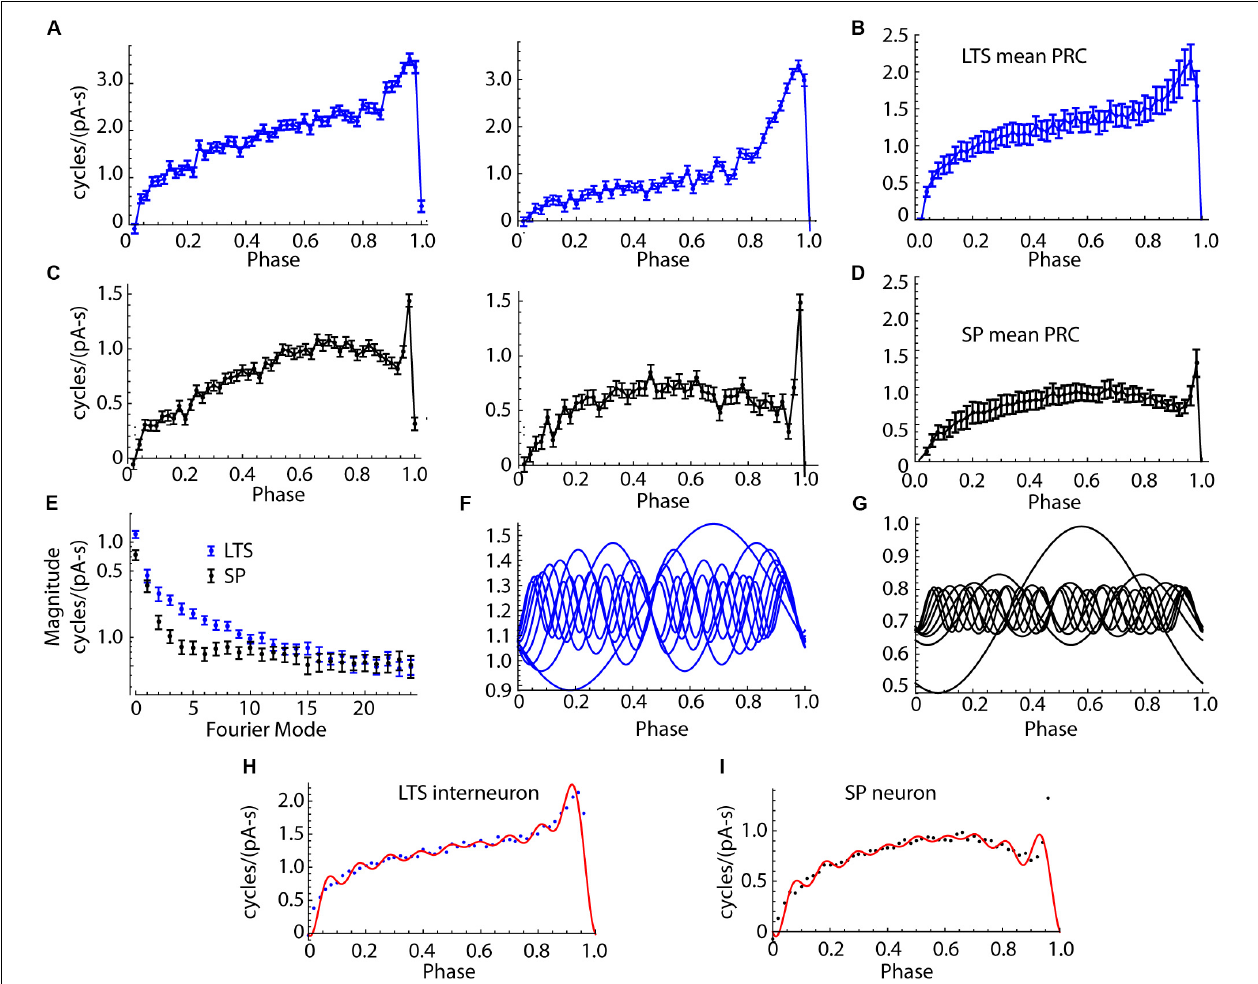
FIGURE 6 | Comparison of PRCs of SP neurons and LTS interneurons. (A) Two example LTS interneuron PRCs. (B) The mean PRC for the sample of 18 LTS interneurons. Error bars are standard errors of the means. (C) Examples PRCs from two SP neurons. (D) Mean PRC for the group of SP neurons. The consistent differences in shape include the more pronounced skew in the LTS interneuron PRC and its broader late peak. SP neurons’ PRCs were more symmetrical, except for a very narrow late peak, only one or two bins wide, at the end of the ISI. (E) Amplitudes of the Fourier modes of the PRCs of LTS interneurons and SP neurons. 26 modes are shown, calculated from the 50 points in the PRC. Mode 0 is the DC component, which is the average amplitude of the PRC. The differences between cell types are confined to the first 10 modes. (F) Modes 0–9 of the average LTS interneuron PRC. (G) Modes 0–9 of the average SP neuron PRC. (H) Mean LTS interneuron PRC, assembled from the modes shown in (F) . Points shown are the original mean PRC. (I) . SP neuron average PRC (points) and PRC reassembled from modes shown in (G) (red